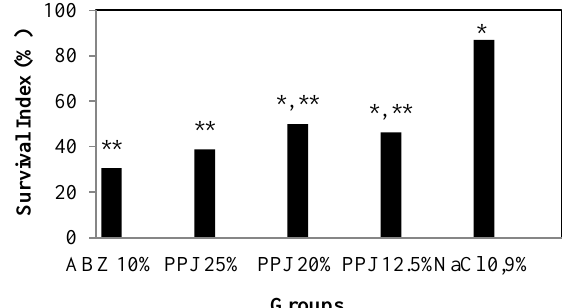
Fig. 4. SI mean of each group: * significantly different from Albendazole 10% w/v, ** significantly different from NaCl 0.9% w/v (p <0.05)